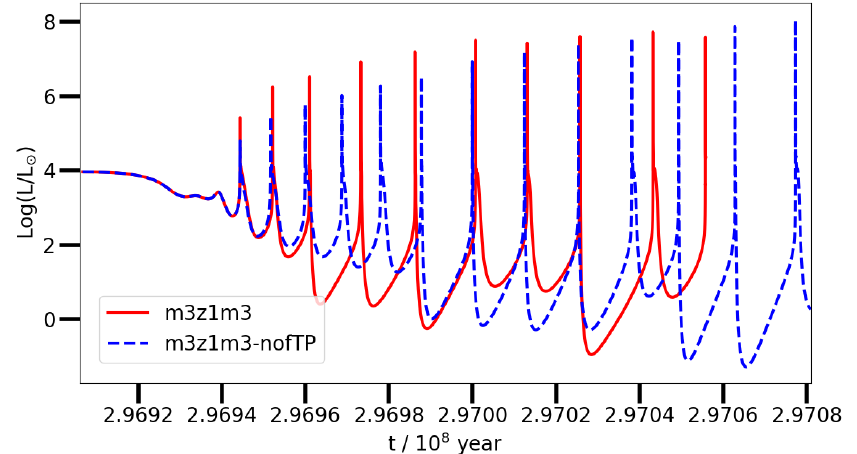
Figure 2. Evolution of He-burning luminosities over time in both m3z1m3 and